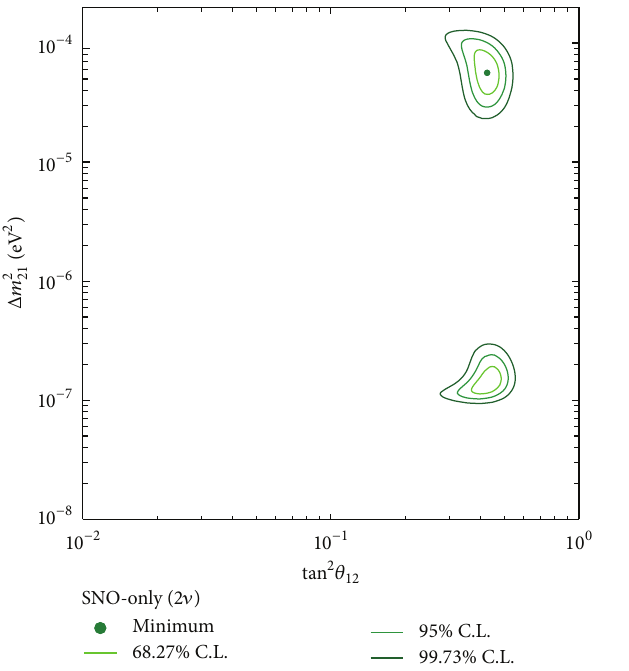
Figure 12: Two-flavor neutrino oscillation analysis contour using only SNO data (taken from [147]).